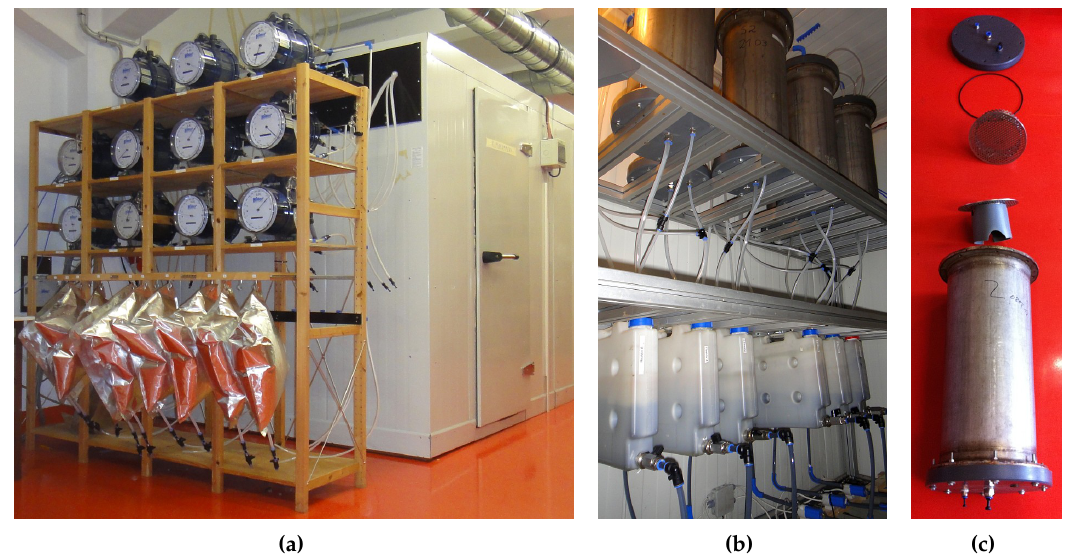
Figure 3. Test setup with ( a ) gas meters and gas storage bags in front of the climate chamber; ( b ) reactors and percolation tanks in the climate chamber; ( c ) components of a single reactor.